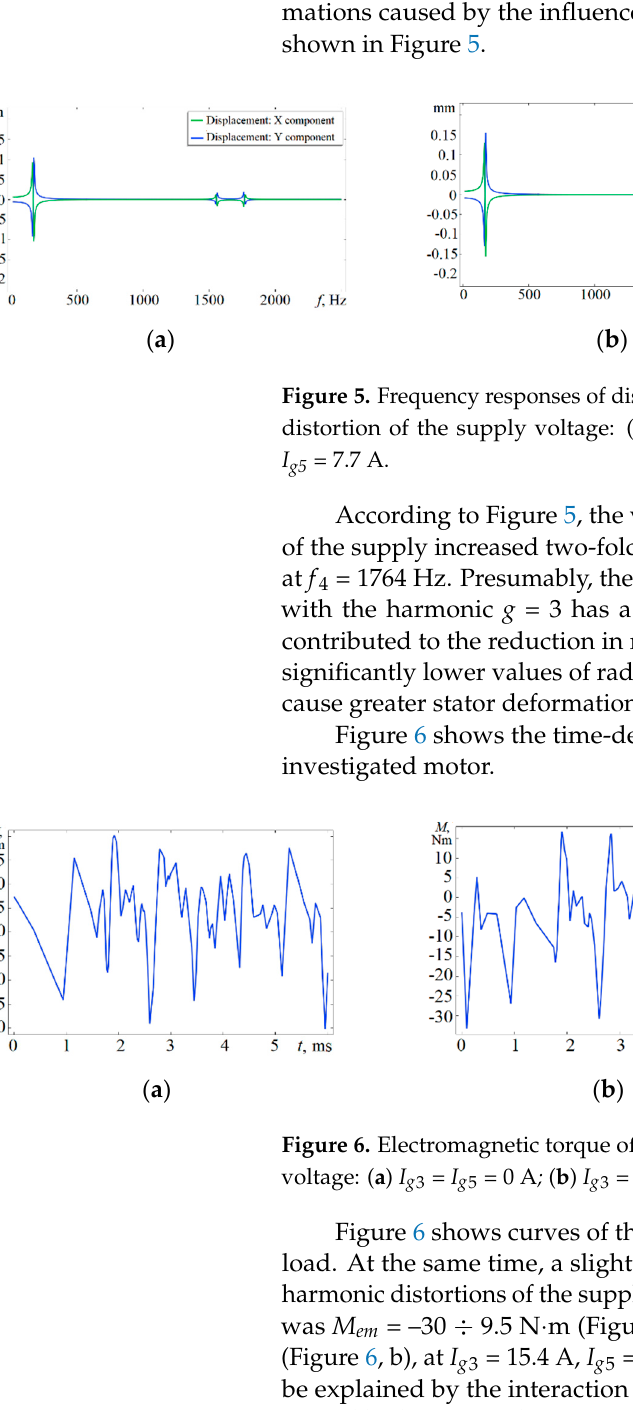
Figure 4. Acoustic radiation pressure of investigated motor with harmonic distortion of the supply voltage: ( a ) I g 3 = I g 5 = 0 A; ( b ) I g 3 = 8.8 A , I g 5 = 3.3 A ; ( c ) I g 3 = 15.4 A , I g 5 = 7.7 A .